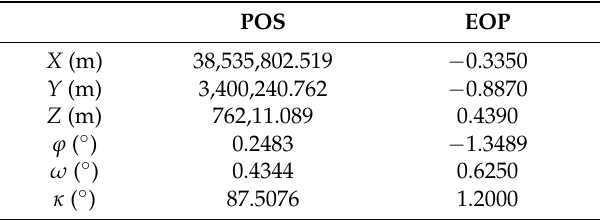
Table 1. POS of the vehicle platform and EOP of the camera aboard.